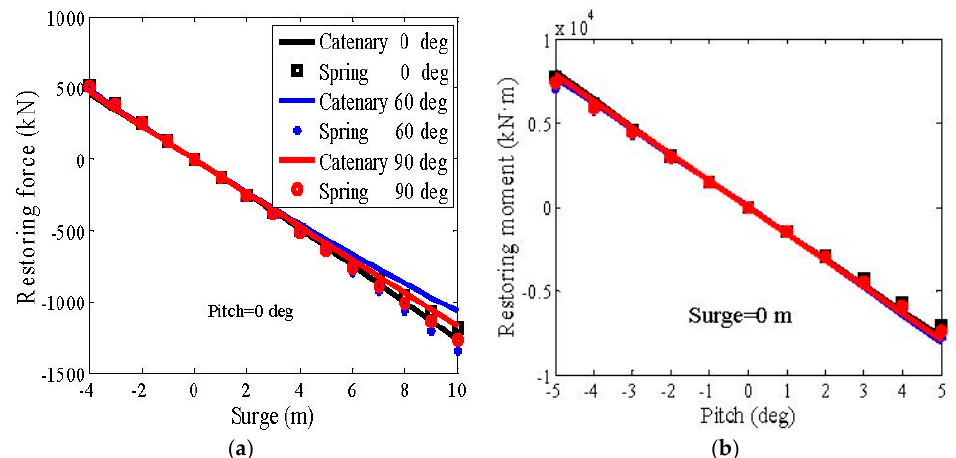
Figure 5. Comparison of ( a ) the surge-restoring force curves and ( b ) the pitch-restoring moment curves between the catenary mooring system and the spring mooring system in three load directions.